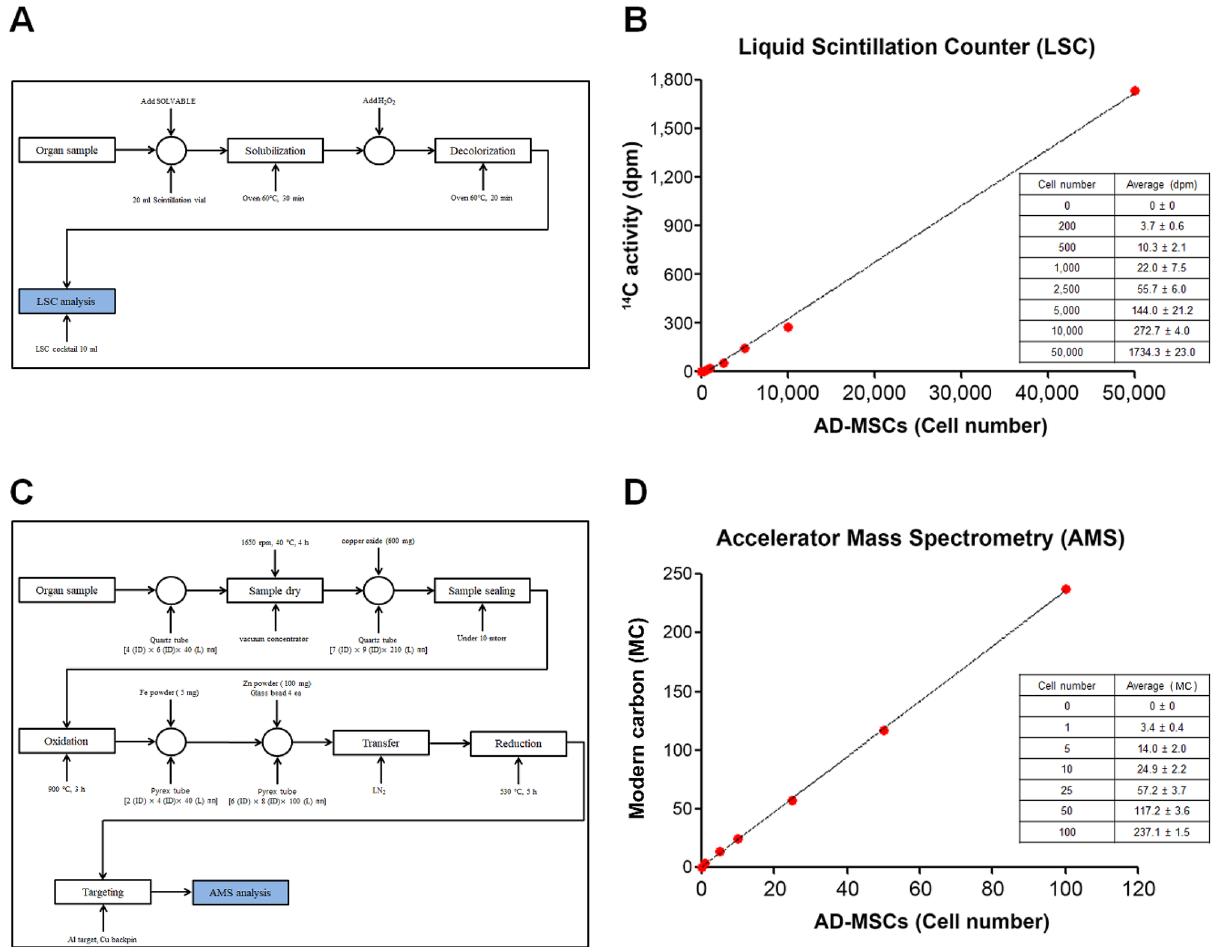
Figure 3. Pretreatment procedure and quantitative curves of LSC and AMS analysis. ( A ) Pretreatment procedure for LSC measurement. ( B ) Calibration curve of LSC using 14 C activity value (dpm) according to cell number (200, 500, 1,000, 2,500, 5,000, 10,000, and 50,000 cells) ( C ) Pretreatment procedure for AMS measurement. ( D ) Calibration curve of AMS using modern carbon (MC) according to cell number (1, 5, 10, 25, 50, and 100 cells). All data are expressed as mean ±